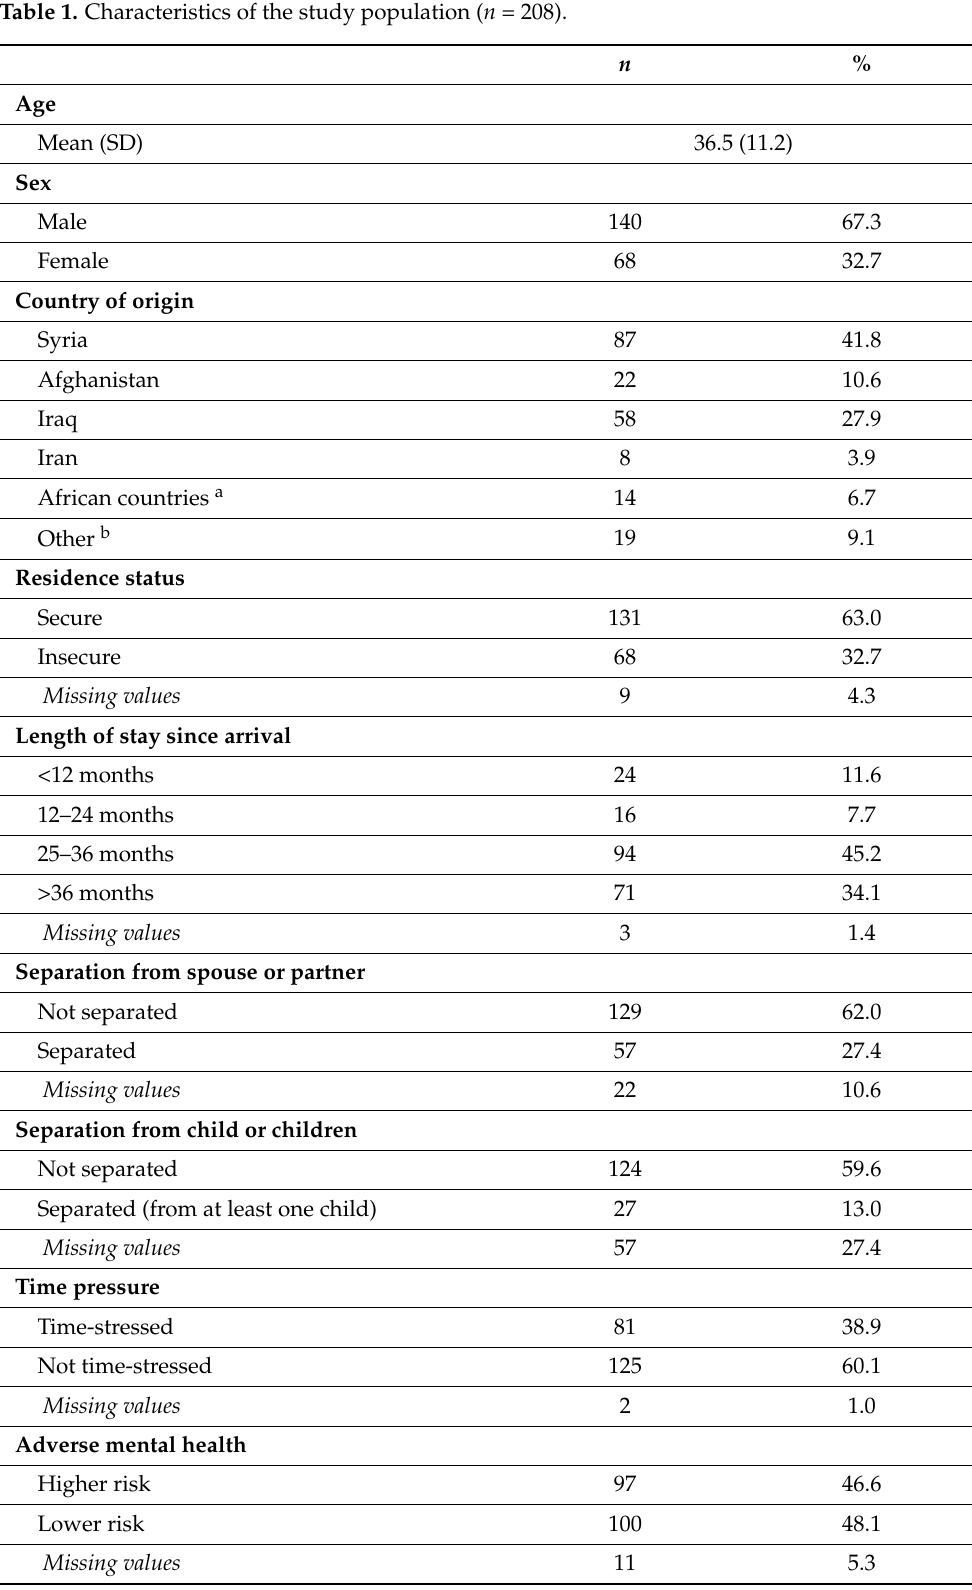
Table 1. Characteristics of the study population ( n =